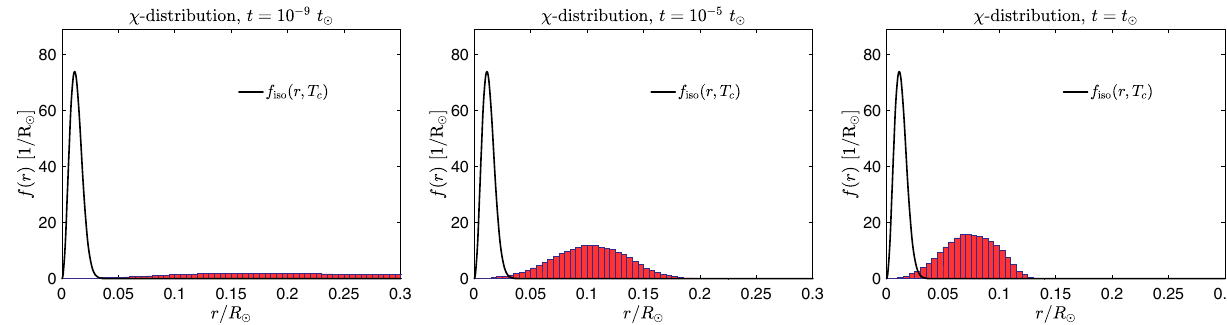
Fig. 7 The radial distribution of χ particles, f num ( r ) , at various times t = 10 − 9 t (cid:9) ( left panel ), t = 10 − 5 t (cid:9) ( middle panel ) and t = t (cid:9) ( right panel ). We use m χ = 100 GeV and δ = 100 keV